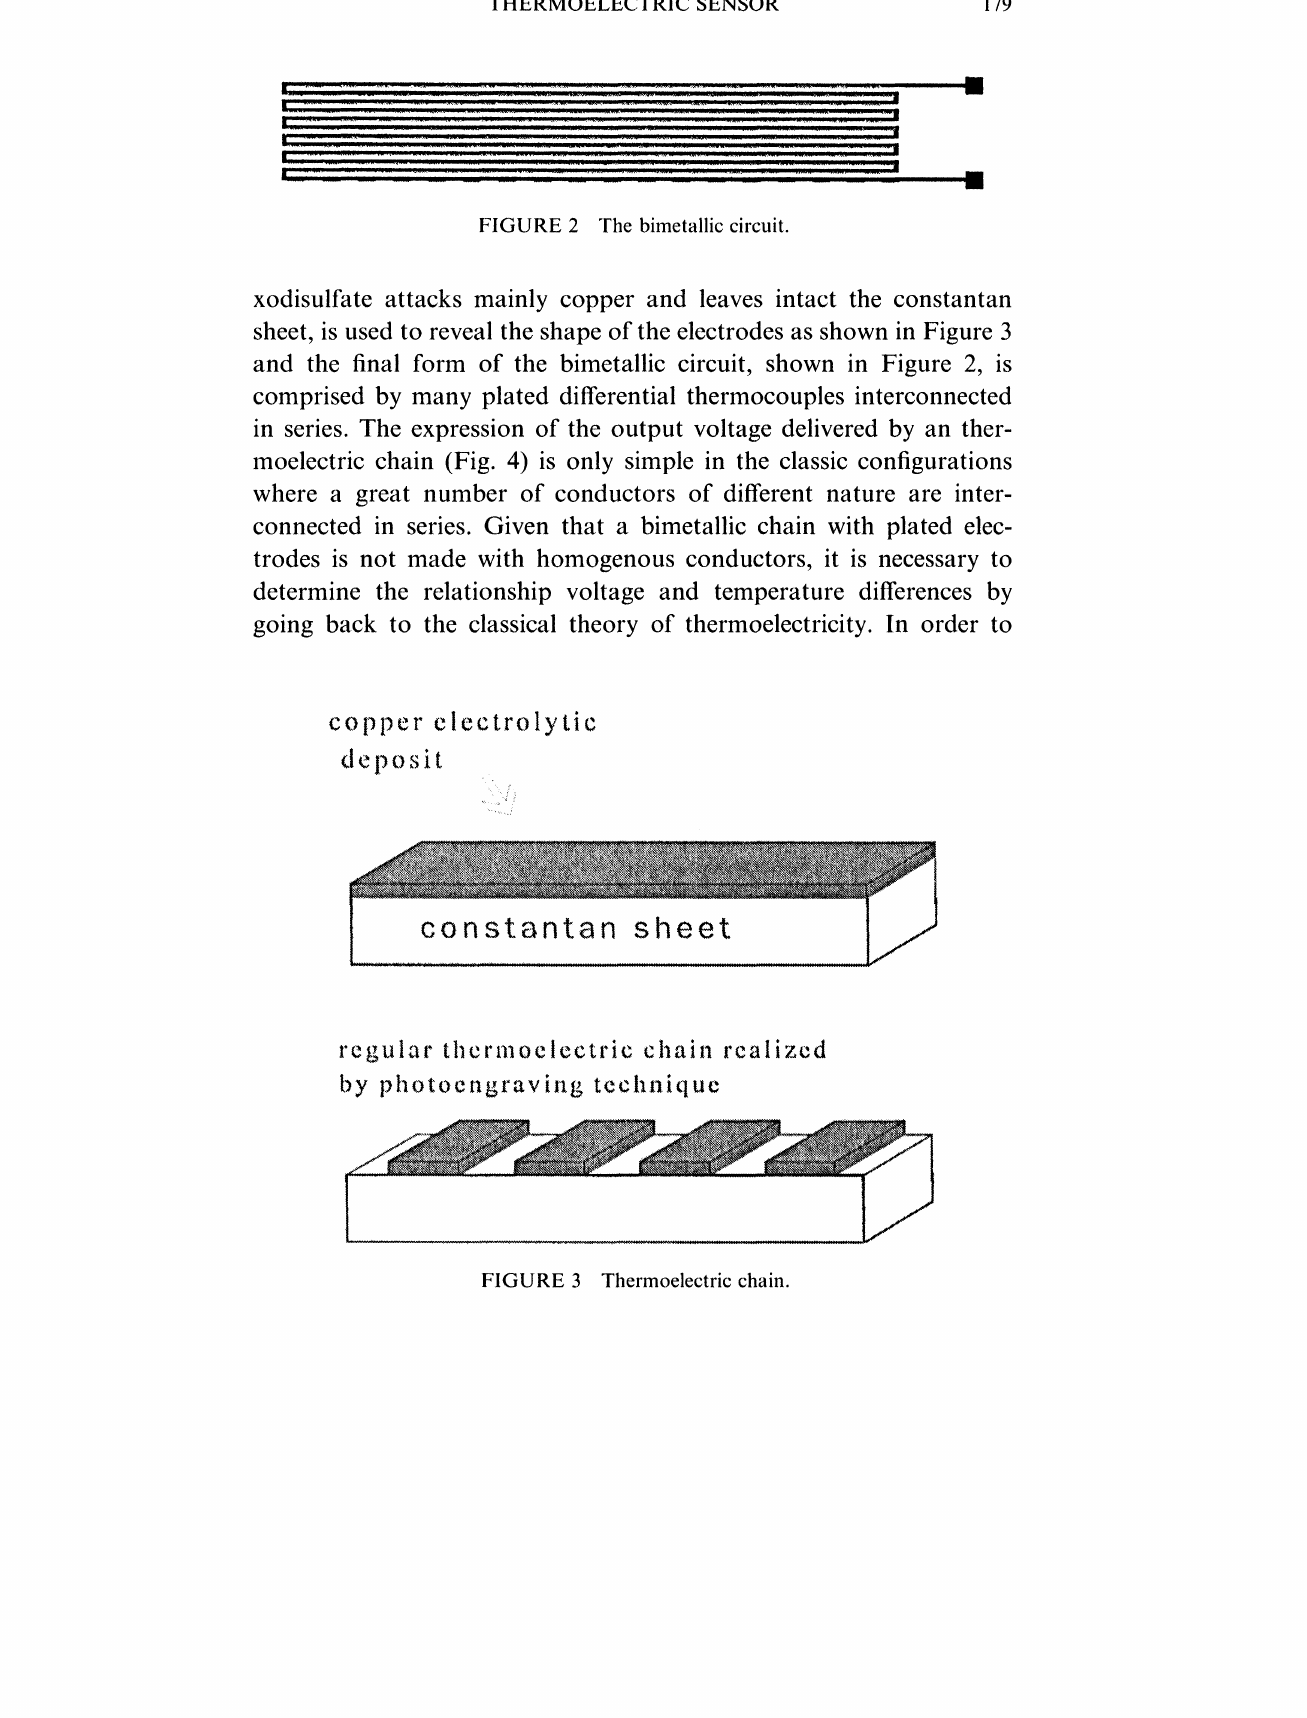
FIGURE 2 The bimetallic circuit.